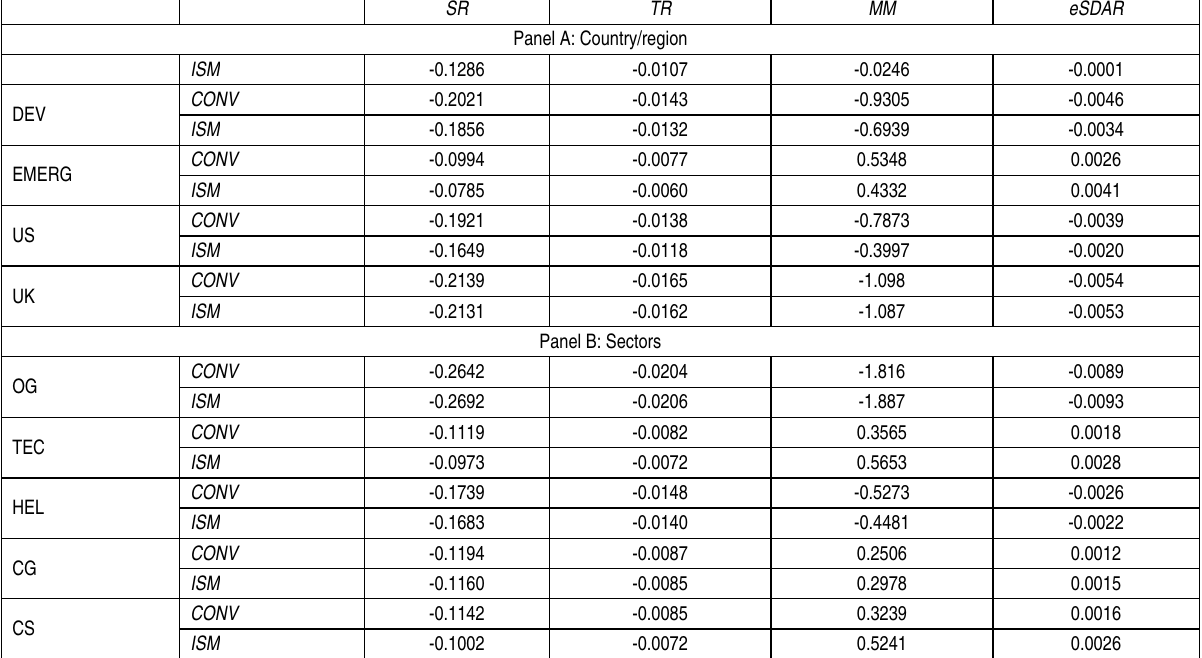
Table 10 (cont.). Sharpe, Treynor, MM and eSDAR ratios during financial crisis